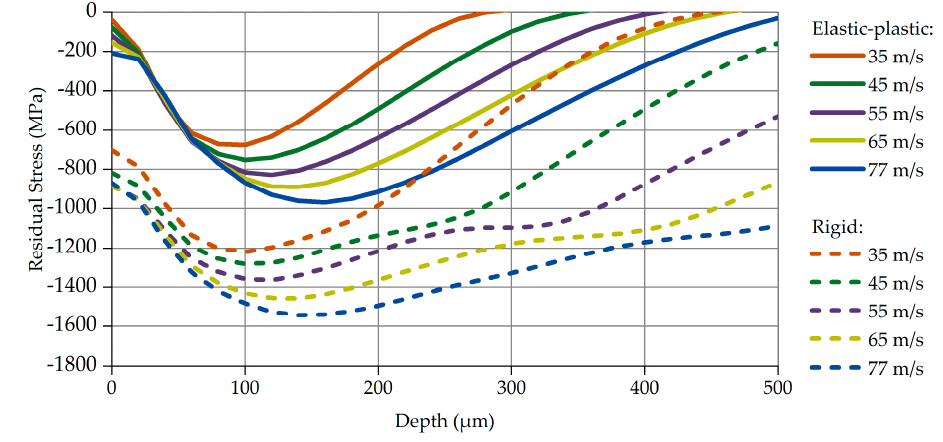
Figure 4. Compressive Residual Stress profiles, for various impact